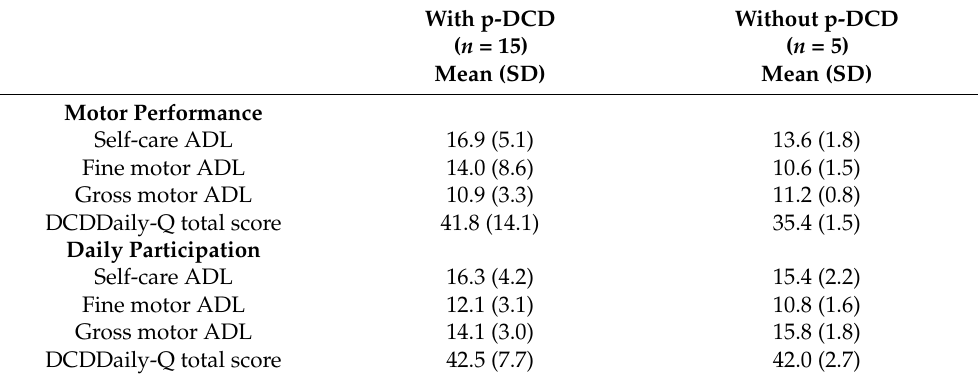
p-DCD = probable Developmental Coordination Disorder, ADL = activities of daily